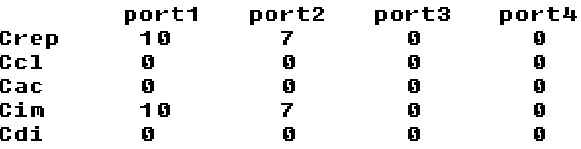
Fig. 10. The simulation result of node 15.